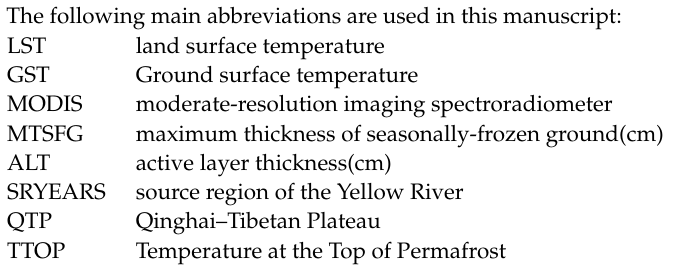
Figure S4: Comparison of the MTSFG estimated by remote sensing and its uncertainty band with observations at nine meteorological stations. The region filled by the blue color is the uncertainty band of the estimated MTSFG, with a 95% confidence level. Table S1: Validation of the mean daily LST estimated by the MODIS product. Table S2: Comparison of the mean value of the observed and remote sensing estimated annual MTSFG at nine meteorological